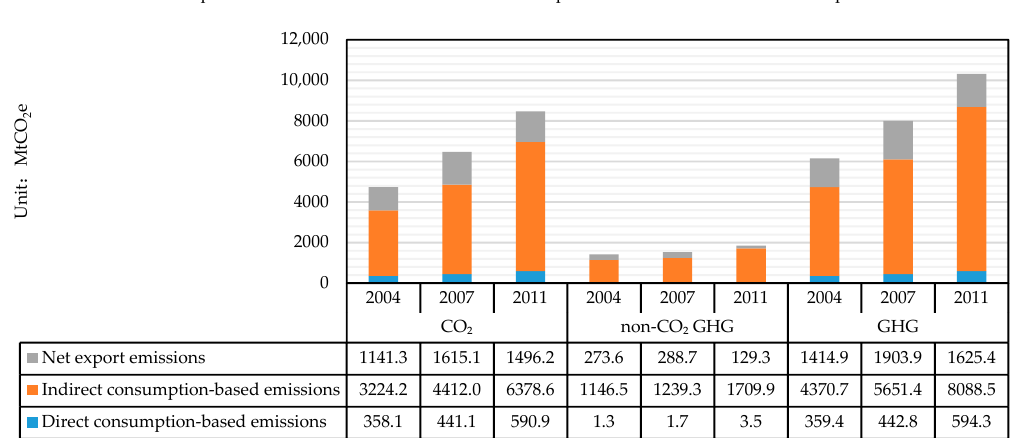
Figure 1. China’s production-based and consumption-based emissions and consumption-based direct and indirect emissions.